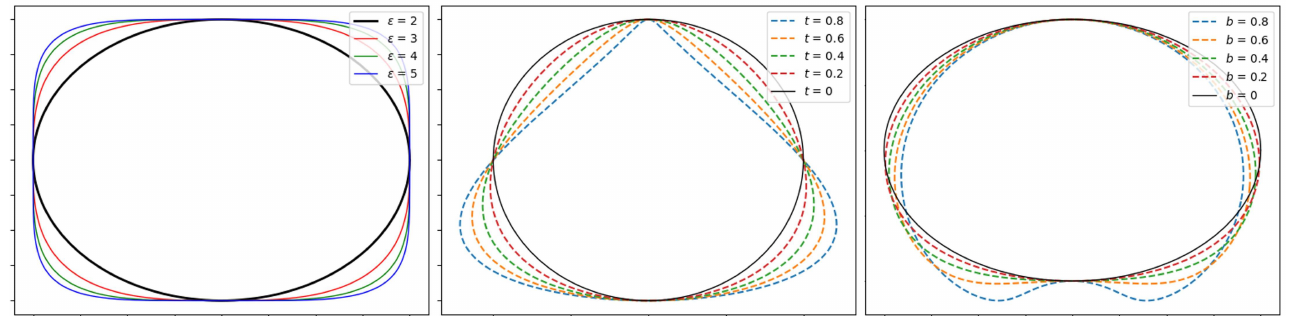
Figure 4. Deformable superellipse modeling capabilities examples. The left image represents the superellipse varying squareness (cid:101) parameter, whereas the middle one depicts the deformable superel- lipse varying tapering t parameter, and the right one portrays the deformable superellipse varying circular bending b